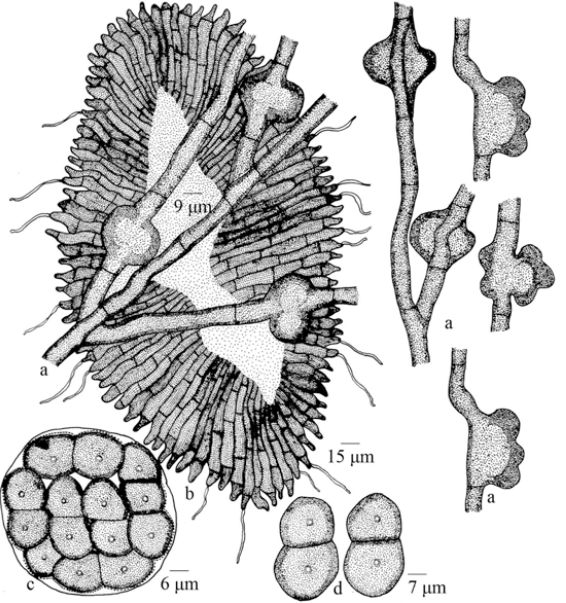
Figure 2. Asteridiella anaxagoreae sp. nov. a - Appressorium; b - Phialide; d - Ascospores; e - Peridial